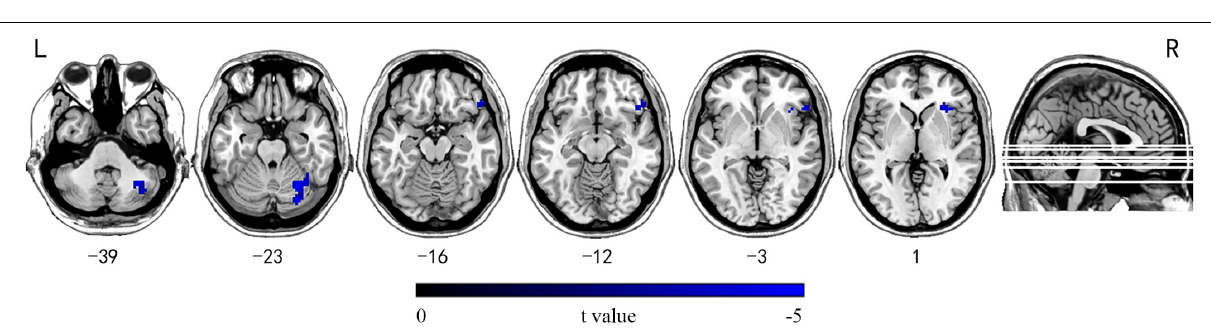
FIGURE 3 | Brain regions showing significantly decreased INT between mTLE patients with longer epilepsy duration and HC subjects. Group differences in INT between the mTLE patients with longer epilepsy duration and HC groups were identified using a two-sample t test. The statistical significance level was set at voxel-wise p < 0.001, cluster-level p < 0.05 (GRF corrected, voxel wise ≥ 30). Patients with longer epilepsy duration showed decreased INT in the right inferior OFG and right cerebellum crus1/6. INT, intrinsic neural timescales; HC, healthy control; mTLE, mesial temporal lobe epilepsy; OFG, orbital frontal gyrus; L, left; R,